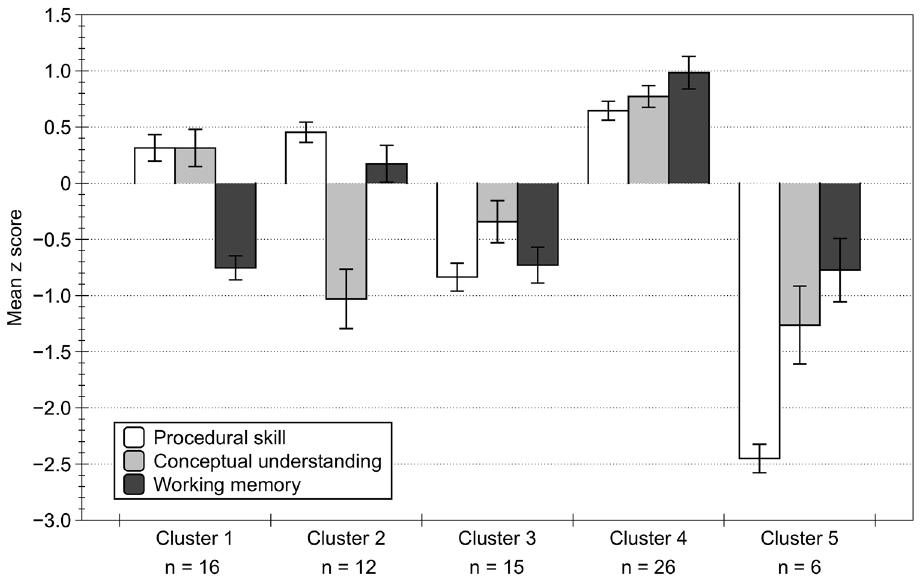
Figure 3. Procedural skill, conceptual understanding and working memory (mean z -scores) for each